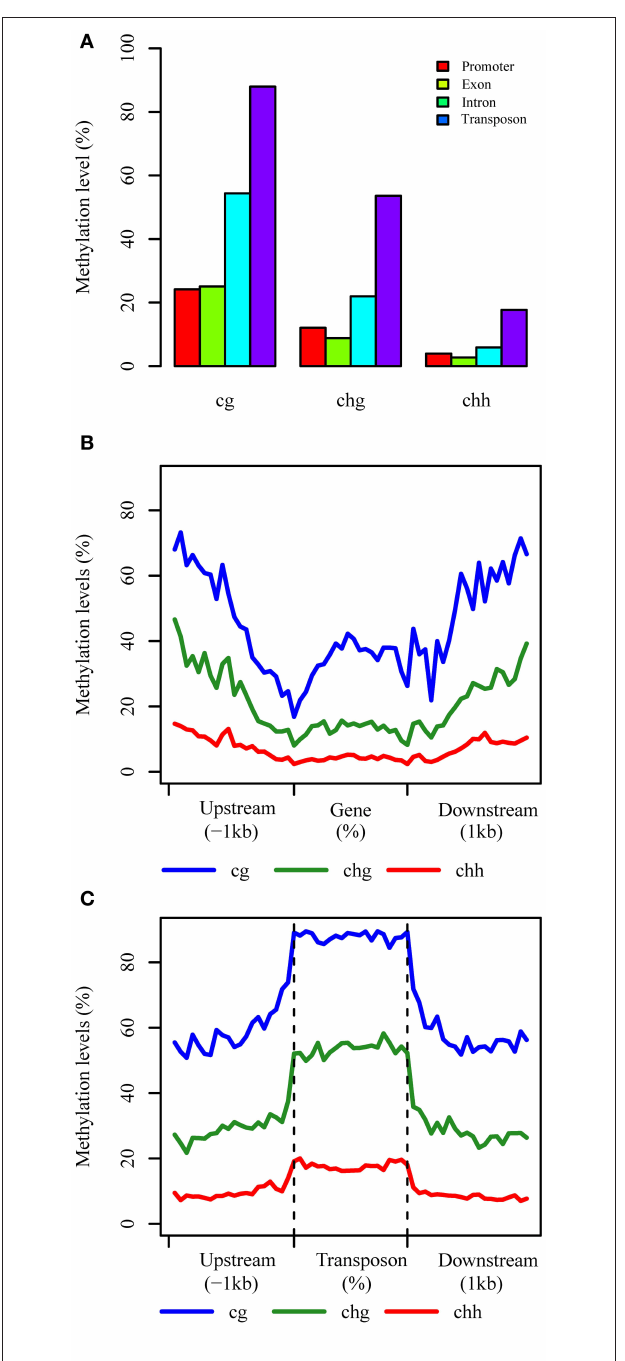
FIGURE 2 | The distributions of each context in different components. (A) Average methylation level in different components, and promoter regions are defined as 200bp region before TSS; (B,C) Methylation patterns of genic and TE regions, respectively at base-pair resolution.